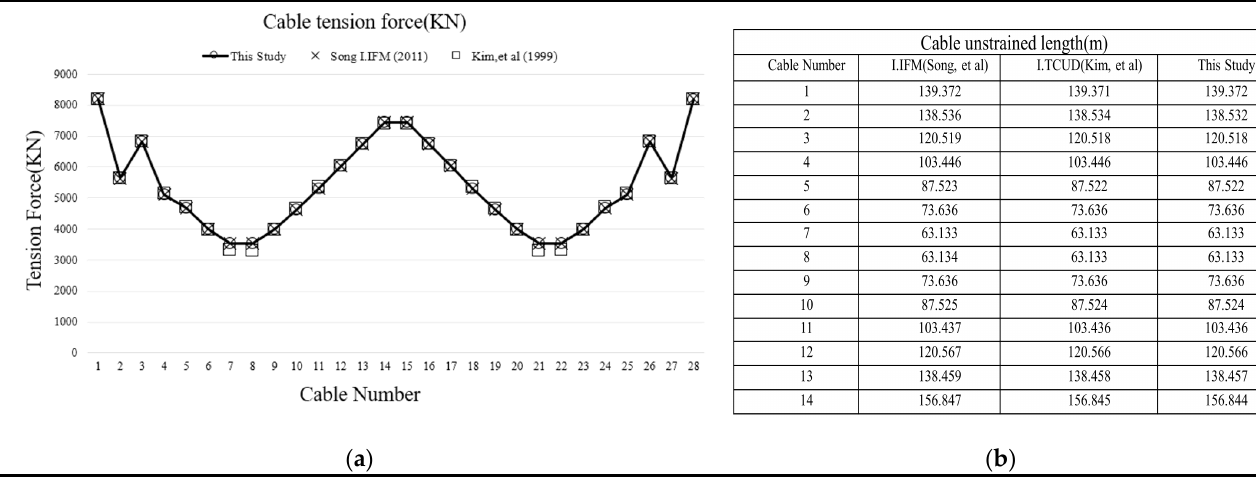
Figure 15. Cable forces and unstrained length in initial state of a cable-stayed bridge: ( a ) Cable tension force; ( b ) Cable unstrained length.